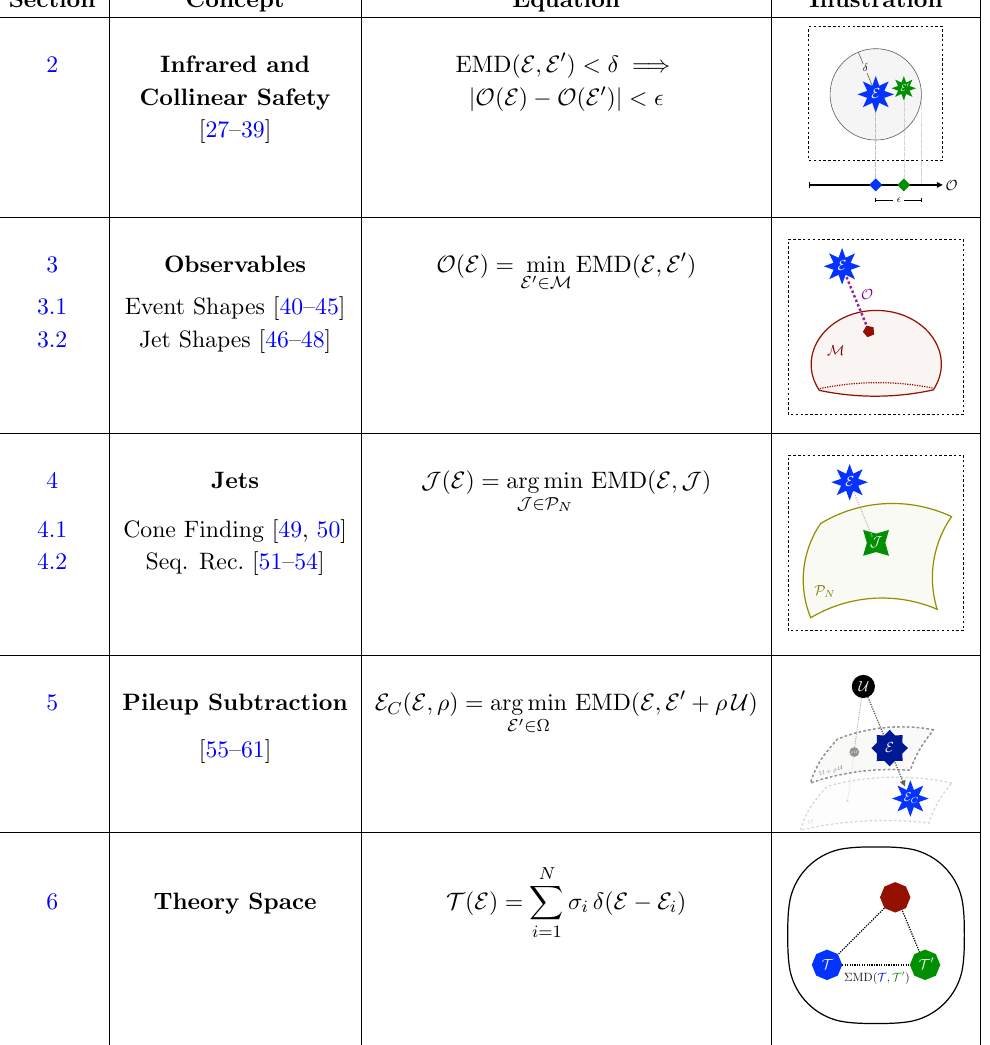
Table 1 . Concepts from quantum (cid:12)eld theory and collider physics, uni(cid:12)ed in this paper as geometric and topological constructions in the space of events. In section 2, IRC safety is identi(cid:12)ed as continuity in this space. In section 3, many classic collider observables are shown to be the shortest distance between the event and a manifold of events. In section 4, popular jet algorithms are derived by projecting the event onto manifolds of N -particle events. In section 5, common